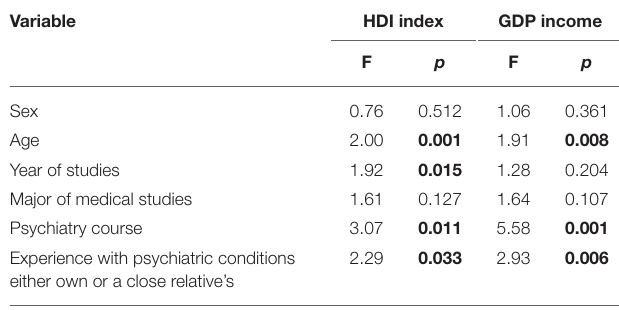
TABLE 4 | Results according to specific variables. TABLE 5 | Analysis of covariance (ANCOVA) of potential confounding